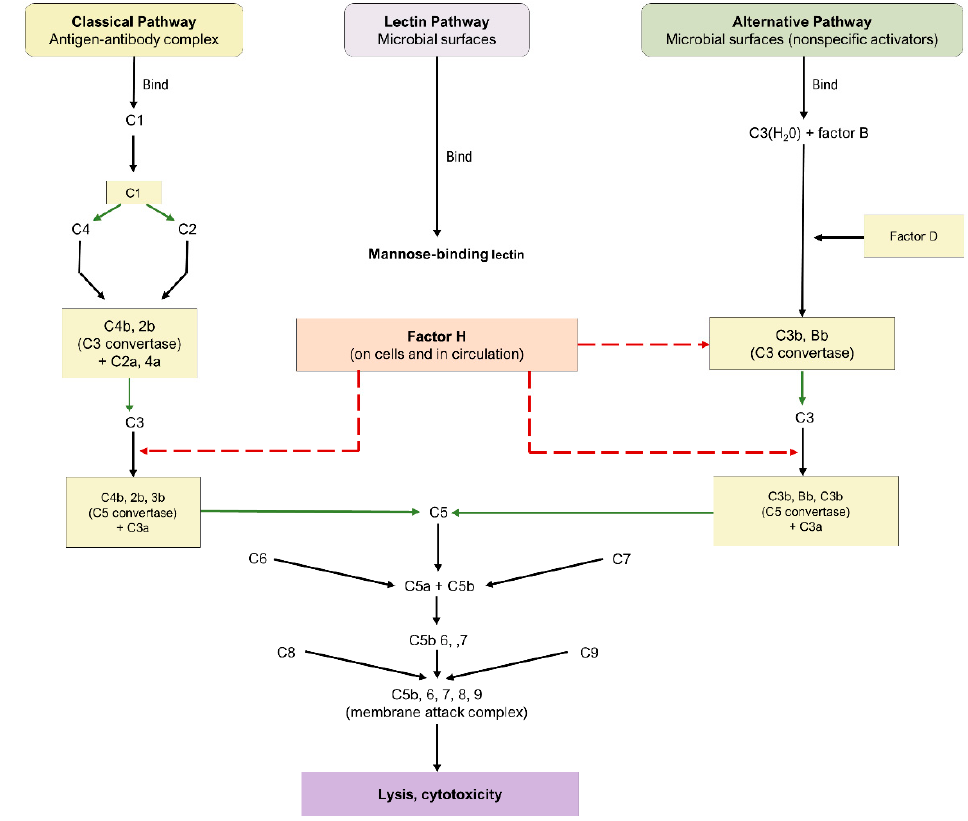
Figure 1. Complement cascade pathway.